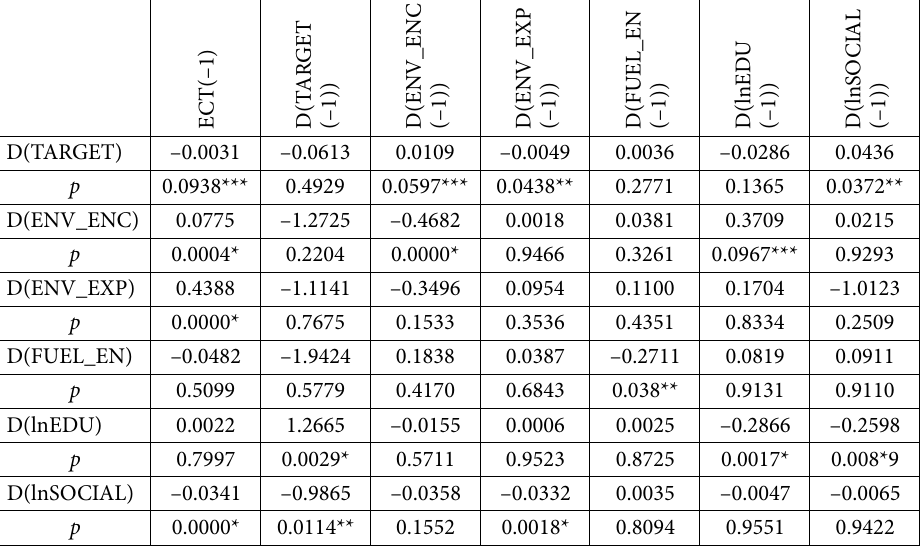
Table 12. Coefficients and probabilities associated to the variables in the equations (source: author’s own